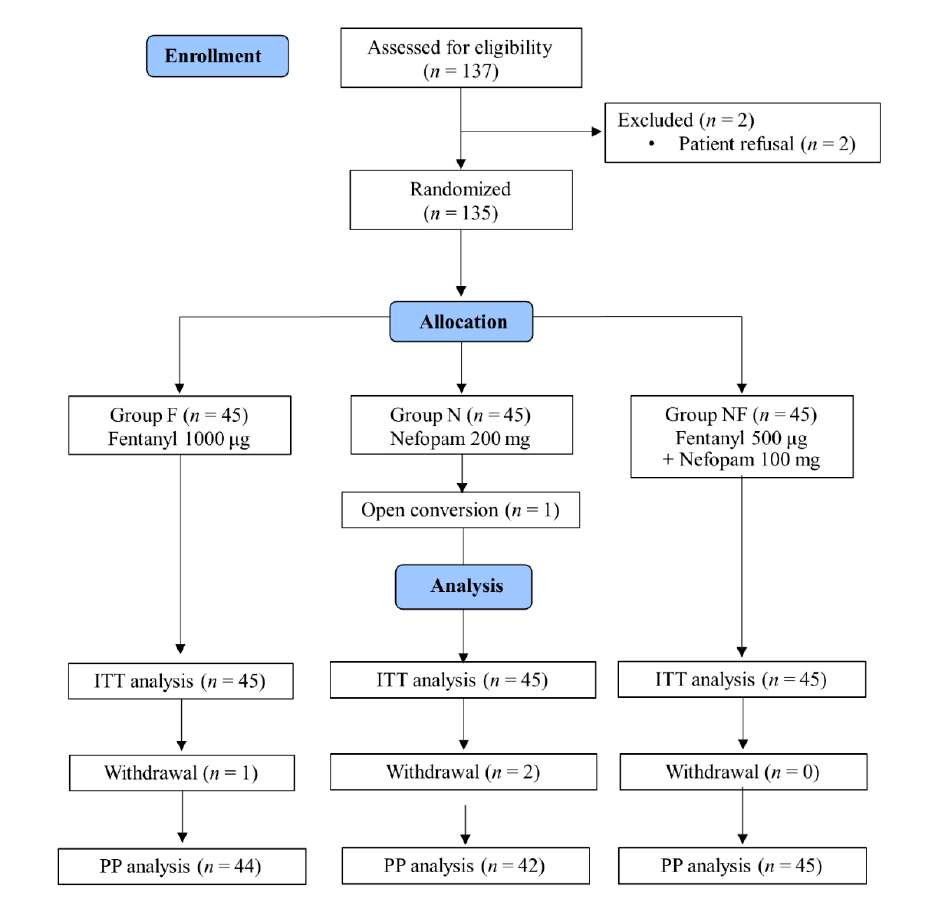
Figure 1. Consolidated Standards of Reporting Trials (CONSORT) flow chart. ITT analysis, intention-to-treat (ITT) analysis; PP analysis, per-protocol analysis. Table 1. Demographic and clinical